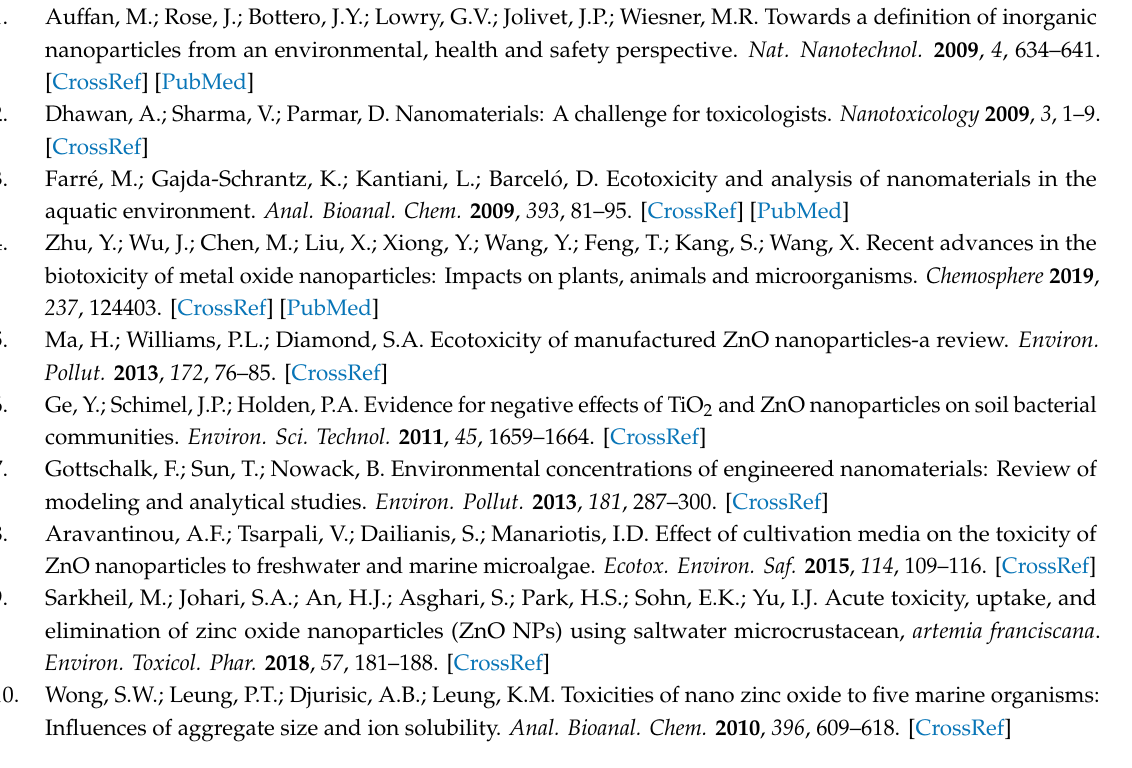
Figure S1. α -Diversity comparison; Table S1. Characterization of ZnO NPs used in the study; Table S2. Summary of 16S RNA Miseq sequences, operational taxonomic units (OTUs), and microbial diversity of sediment samples; Table S3. Carbon sources in Biolog